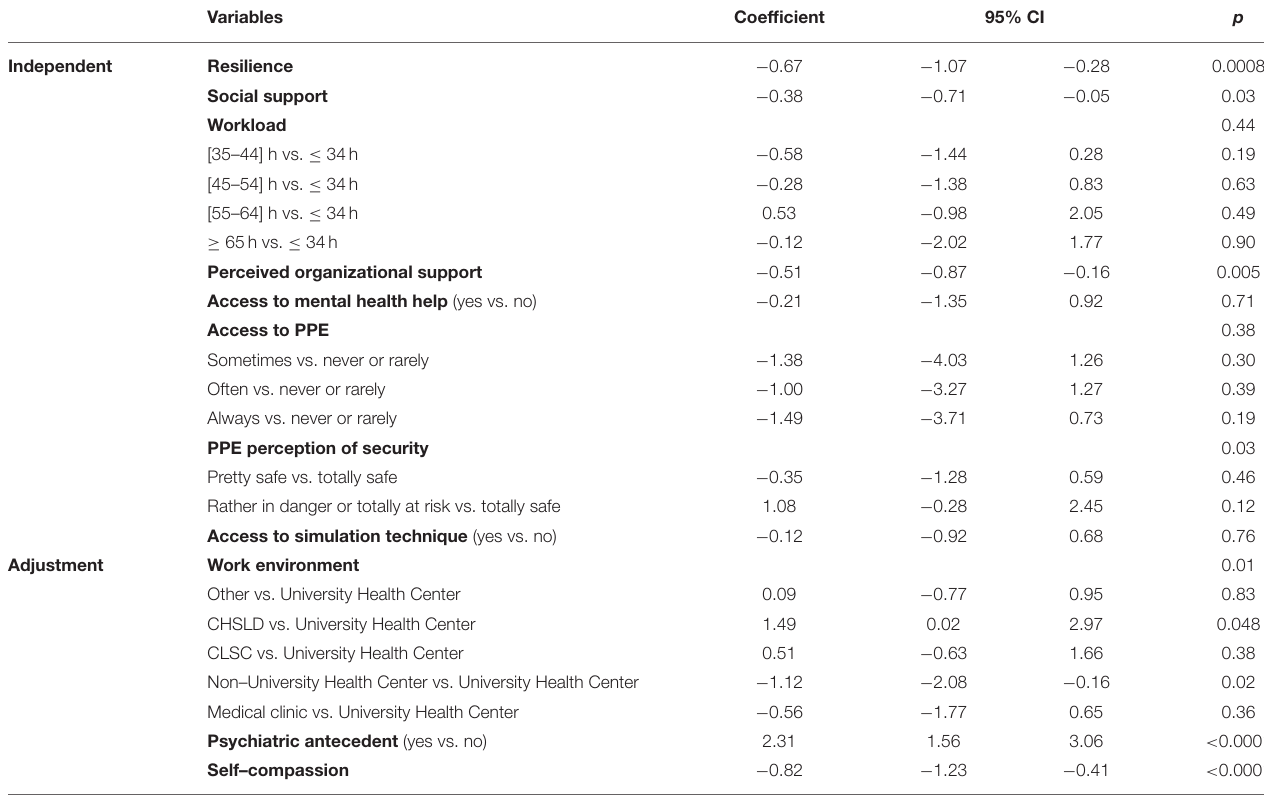
TABLE 9 | Adjusted coefficient, 95% confidence interval and p -values from multivariable linear regression model with self-compassion variable for anxiety symptoms among healthcare workers ( n = 420). Variables Coefficient